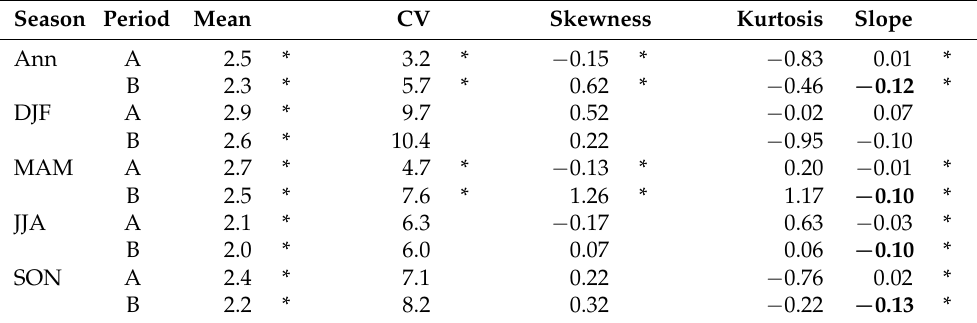
Table 8. Selected statistical characteristics of mean annual (Ann) and seasonal (DJF, MAM, JJA, and SON) wind speed series in the Czech Republic in the 1961–1990 (A) and 1991–2020 (B) periods: means are in m s − 1 , coefficients of variation (CV) in %, linear trends in m s − 1 /10 years (in bold statistically significant at the 0.05 significance level). An asterisk * indicates statistically significant differences of a given characteristic between two 30-year